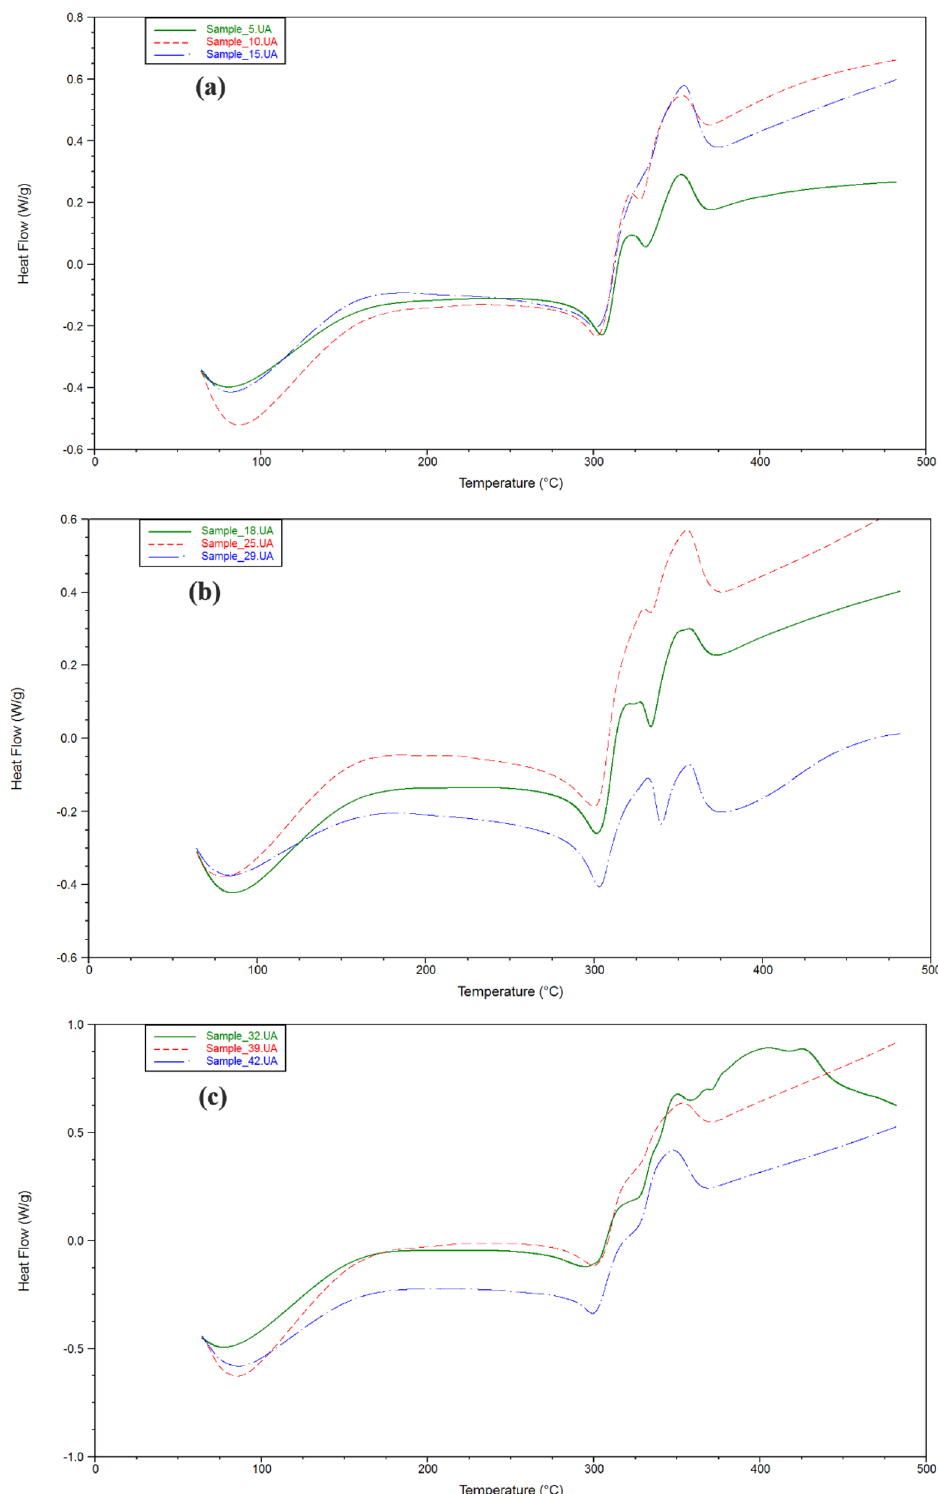
Figure 4. DSC analysis of ( a ) Samples 5 , 10 , 15 ; ( b ) Samples 18 , 25 , 29 ; ( c ) Samples 32 , 29 , 42 ; ( d ) Samples 48 , 51 , 57